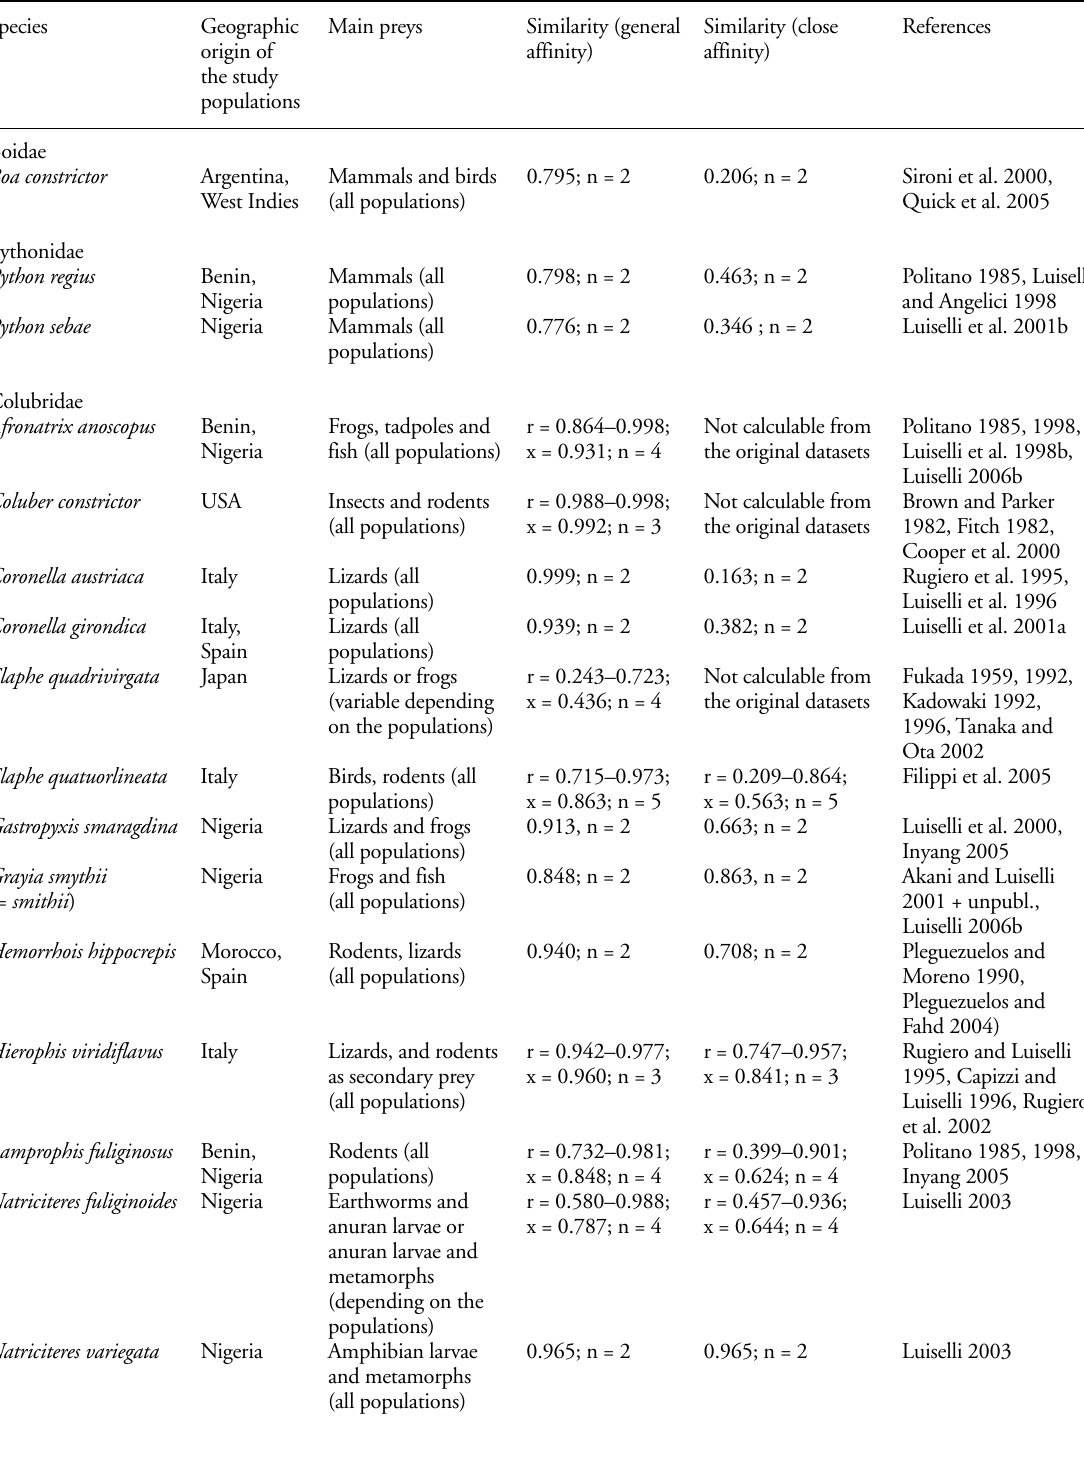
Table 2. Summary of the interpopulation variation in snake dietary composition, assessed by Pianka’s (1986) similarity equation. Symbols: r = range; x = mean; n = number of populations